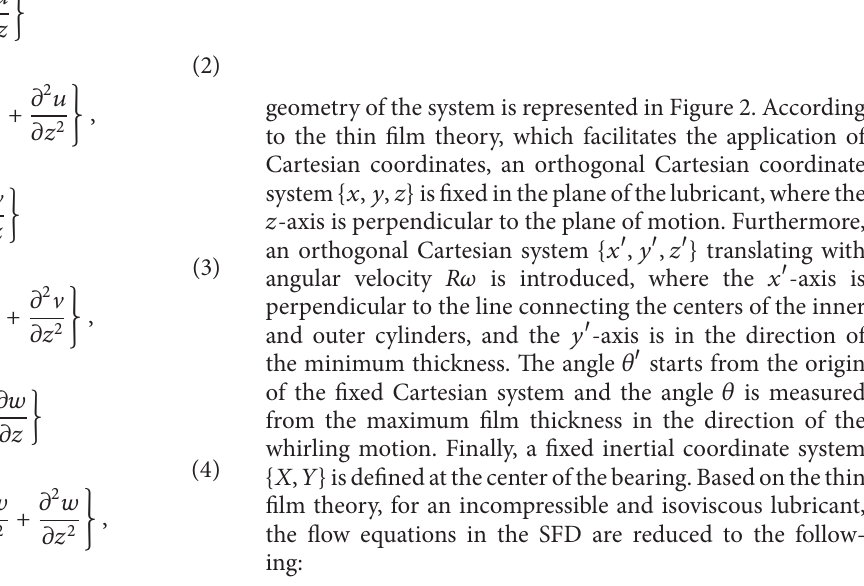
Figure 2: Squeeze film damper geometry and coordinate